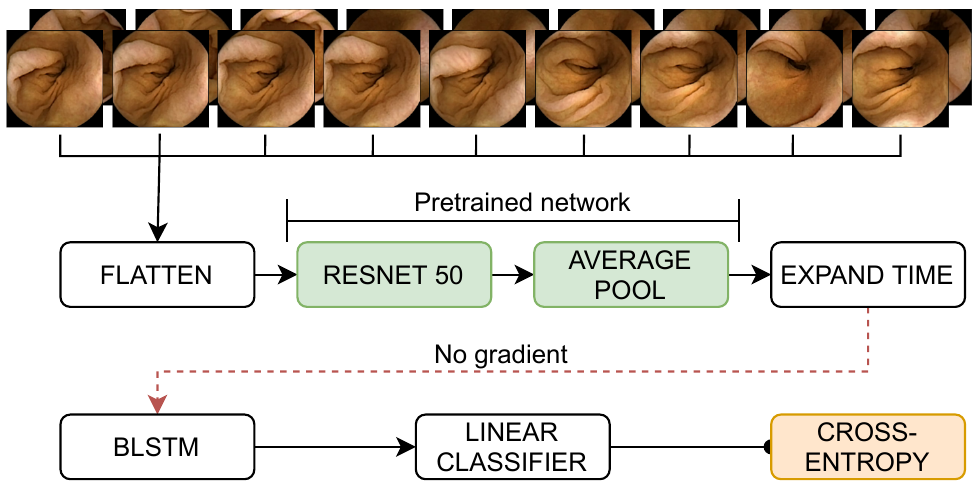
Figure 3. Architecture of the proposed method. Here BLSTM is a Bidirectional Long Short-Term Memory layer. The FLATTEN block removes the temporal axis, flattening over the batch axis, as required per the convolutional blocks in the RESNET 50 block. Likewise, EXPAND TIME recovers the temporal axis for the BLSTM block. The LINEAR CLASSIFIER is a dense layer without any activation, and its outputs are fed into the CROSS-ENTROPY loss (in yellow). The dashed red line denotes that the errors propagated from the classification loss do not change the embeddings learned by the pre-trained network (in